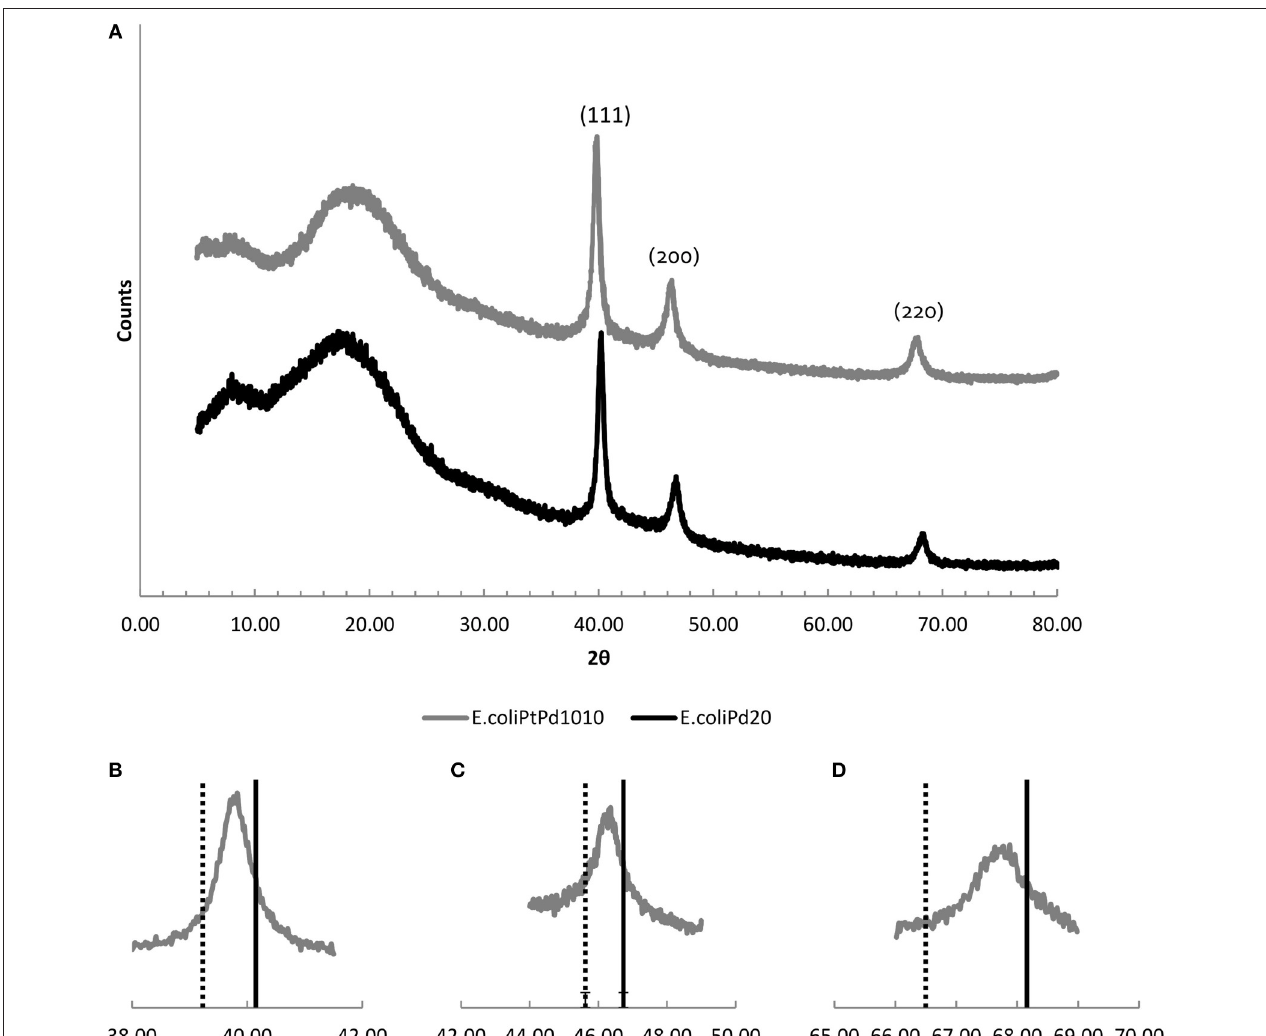
FIGURE 5 | (A) XRD patters of E. coli -Pt/Pd (10%:10%; top, gray) compared to E. coli -Pd (20%; bottom, black) Slight peak shifts to the left can be observed with the bimetallic catalyst. (B–D) show the individual peaks for the (111), (200), and (220) facets, respectively. The broken line indicates the peak positions for Pt/C (from